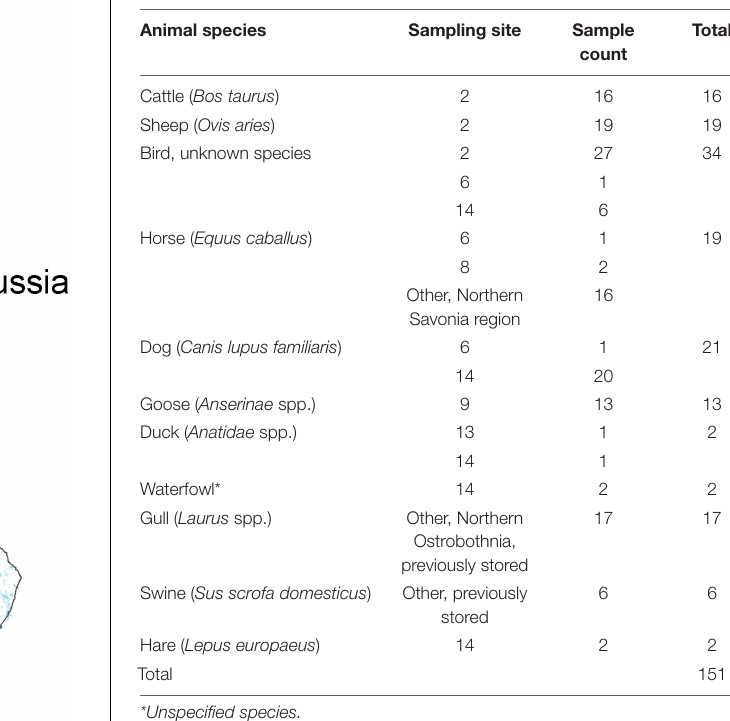
TABLE 1 | Summary of fecal samples collected and